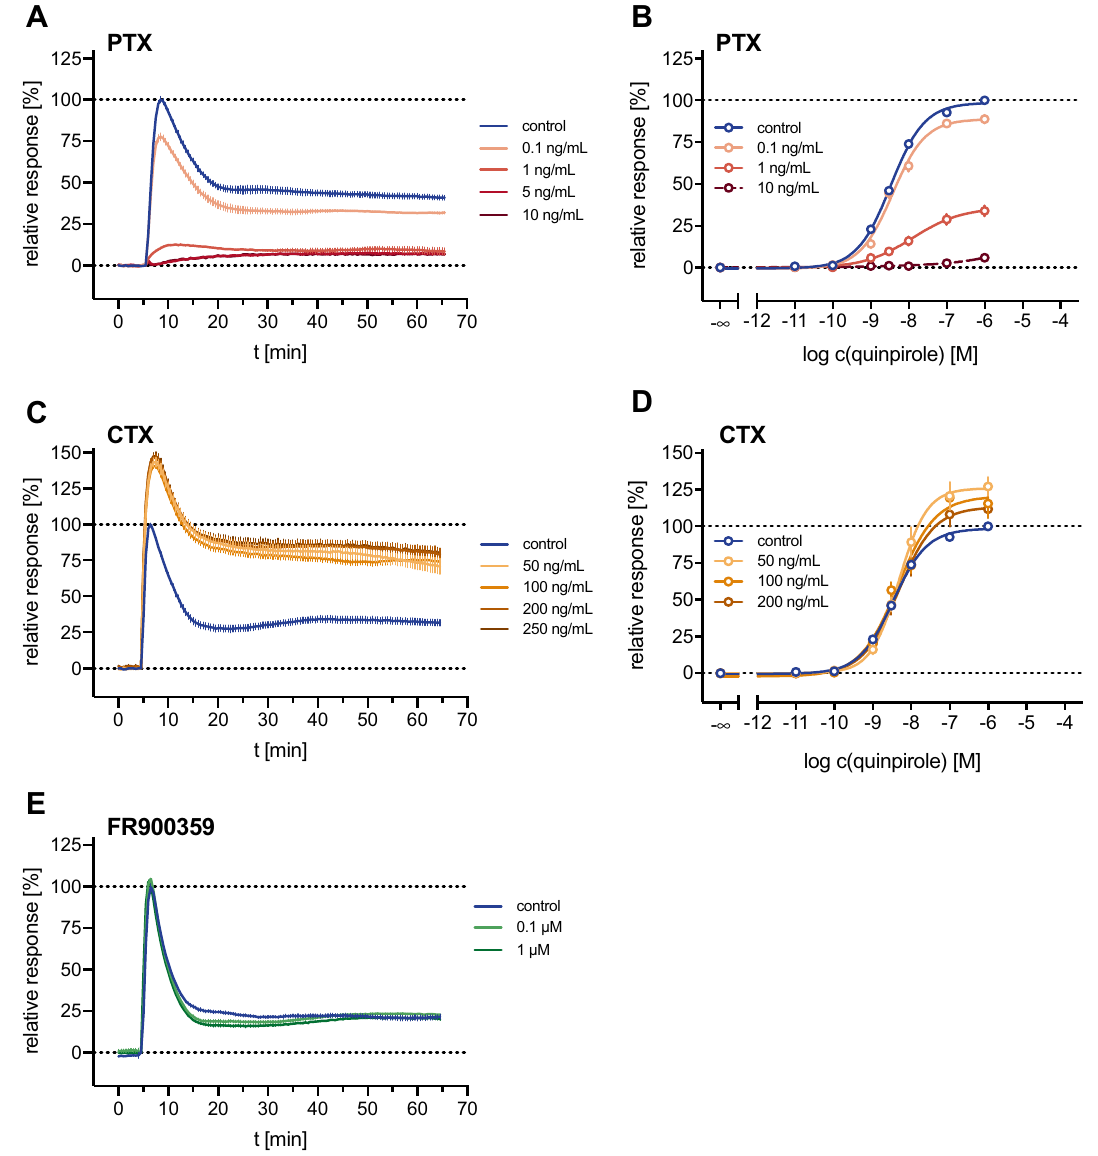
Figure 6. Effects of PTX, CTX and FR900359, capable of silencing G i/o , G s and G q signalling, respectively, on the quinpirole induced DMR response in CHO-K1 hD 2long R cells. ( A , C , E ) Representative recordings of the quinpirole (1 μM) induced response of untreated cells (control) and cells pretreated with pertussis toxin (PTX) ( A ), cholera toxin (CTX) ( C ) or FR900359 ( E ). Data were normalised to the maximum change in wavelength shift induced by quinpirole (1 μM) observed in untreated CHO-K1 hD 2long R cells (100%) and a buffer control (0%). ( B ) Concentration–response curves of quinpirole resulting from DMR measurements in the absence (control) or presence of PTX at different concentrations. Cells were pretreated with PTX for about 20 h. ( D ) Concentration–response curves of quinpirole resulting from DMR measurements in the absence (control) or presence of CTX at different concentrations. Cells were pretreated with CTX for about 20 h. In the case of blocking G q signalling by FR900359 ( E ), cells were incubated with FR900359 for 2 h before the addition of quinpirole and subsequent measurement. Data in ( B,D) represent means ± SEM of three independent experiments, each performed in